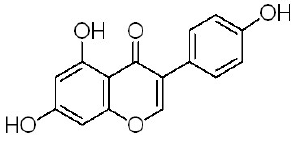
Figure 1. The chemical structure of genistein.